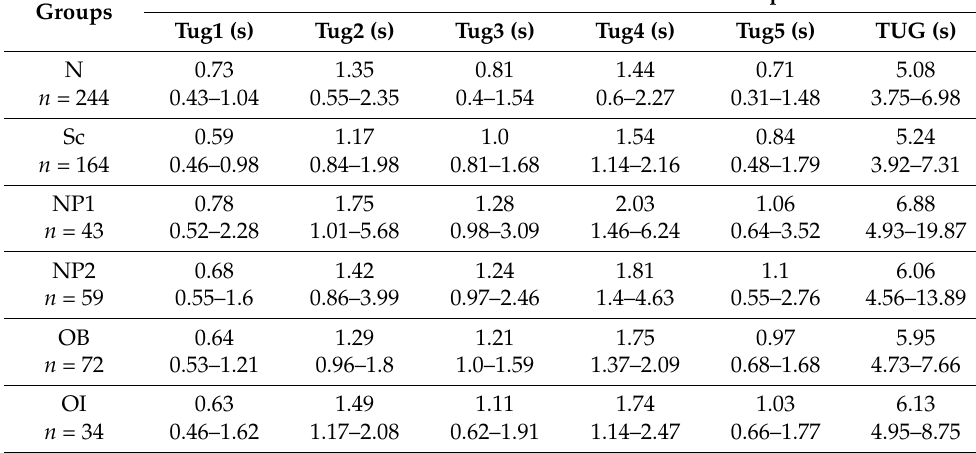
Table 2. The results of the individual components and the total time of the TUG test in reference and in the studied groups of patients.